Question: Generate an informative caption for the figure above.
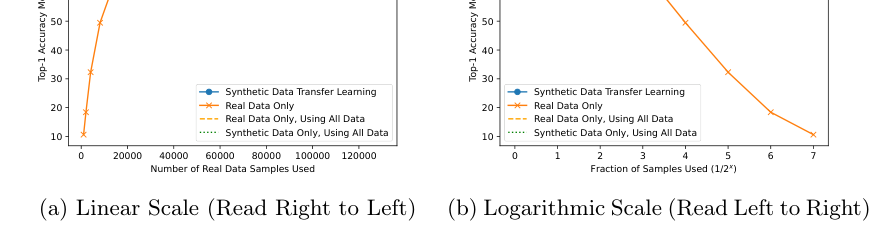
Answer: Training on a reduced real dataset Top-1 accuracy of reducing the amount of real training data with (blue, same as Figure 3) and without (orange) synthetic data transfer learning.